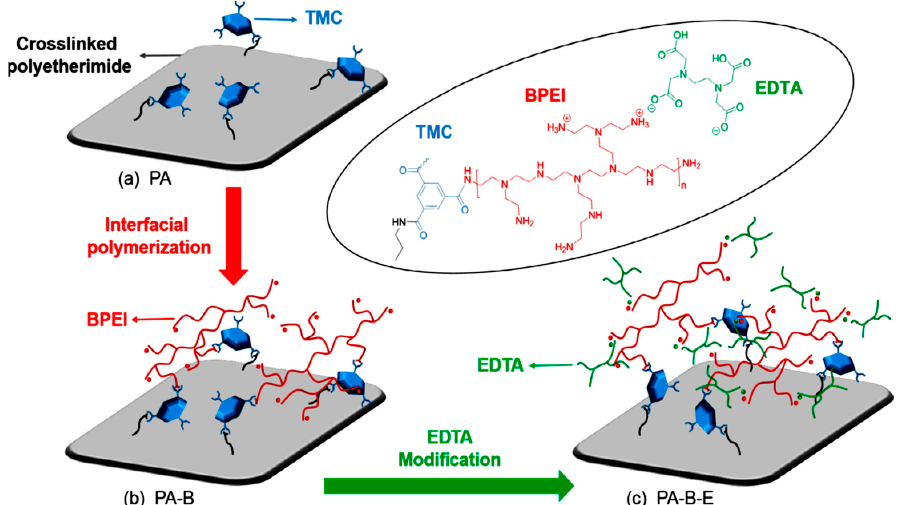
Figure 10. ( a ) PA membrane obtained from cross-linked polyetherimide support via interfacial polymerization between amine groups on the top layer and TMC; ( b ) PA-B membrane obtained via interfacial polymerization with BPEI; ( c ) PA-B-E membrane obtained via EDTA-modification [87].